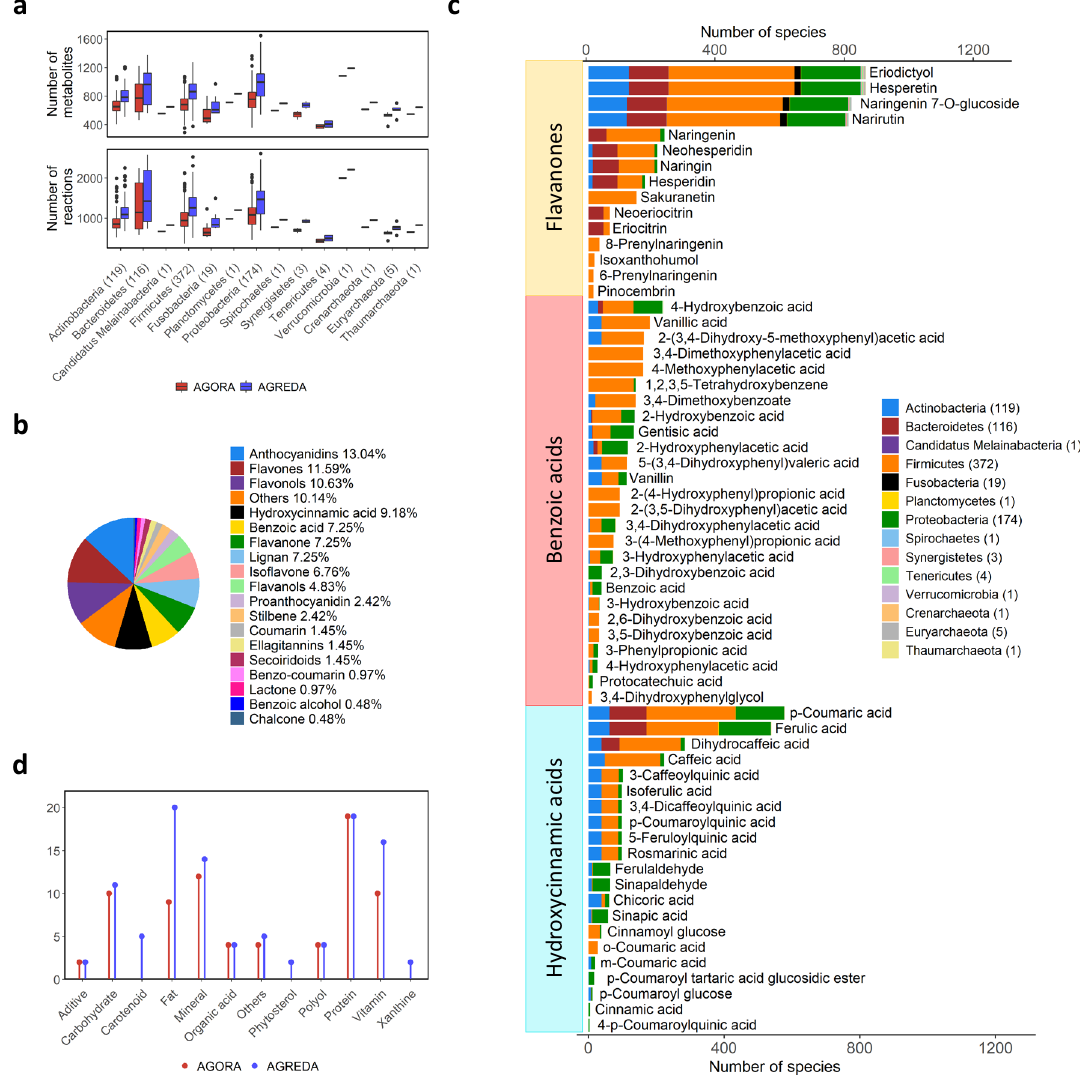
Fig. 2 Main features of AGREDA. a Boxplots depict for each phylum the number of metabolites and reactions of its associated strains in AGORA (red) and AGREDA (blue). Bottom and top of the boxes denote the fi rst and third quartiles, respectively, and whiskers represent the values within 1.5 interquartile range above and below the box. Center line represents the median value. The number of strains per phylum is shown in brackets. Blocked reactions and metabolites were excluded from metabolic models derived from AGORA and AGREDA; b Distribution of the 179 phenolic compounds added by AGREDA separated in 19 families. c Degradation capabilities for three families of phenolic compounds present in AGREDA. The total number of strains in each phylum is reported in brackets; d Other families of compounds in the diet included in AGREDA and